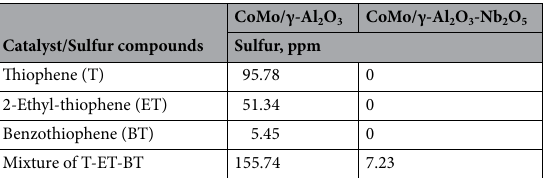
Catalyst/Sulfur